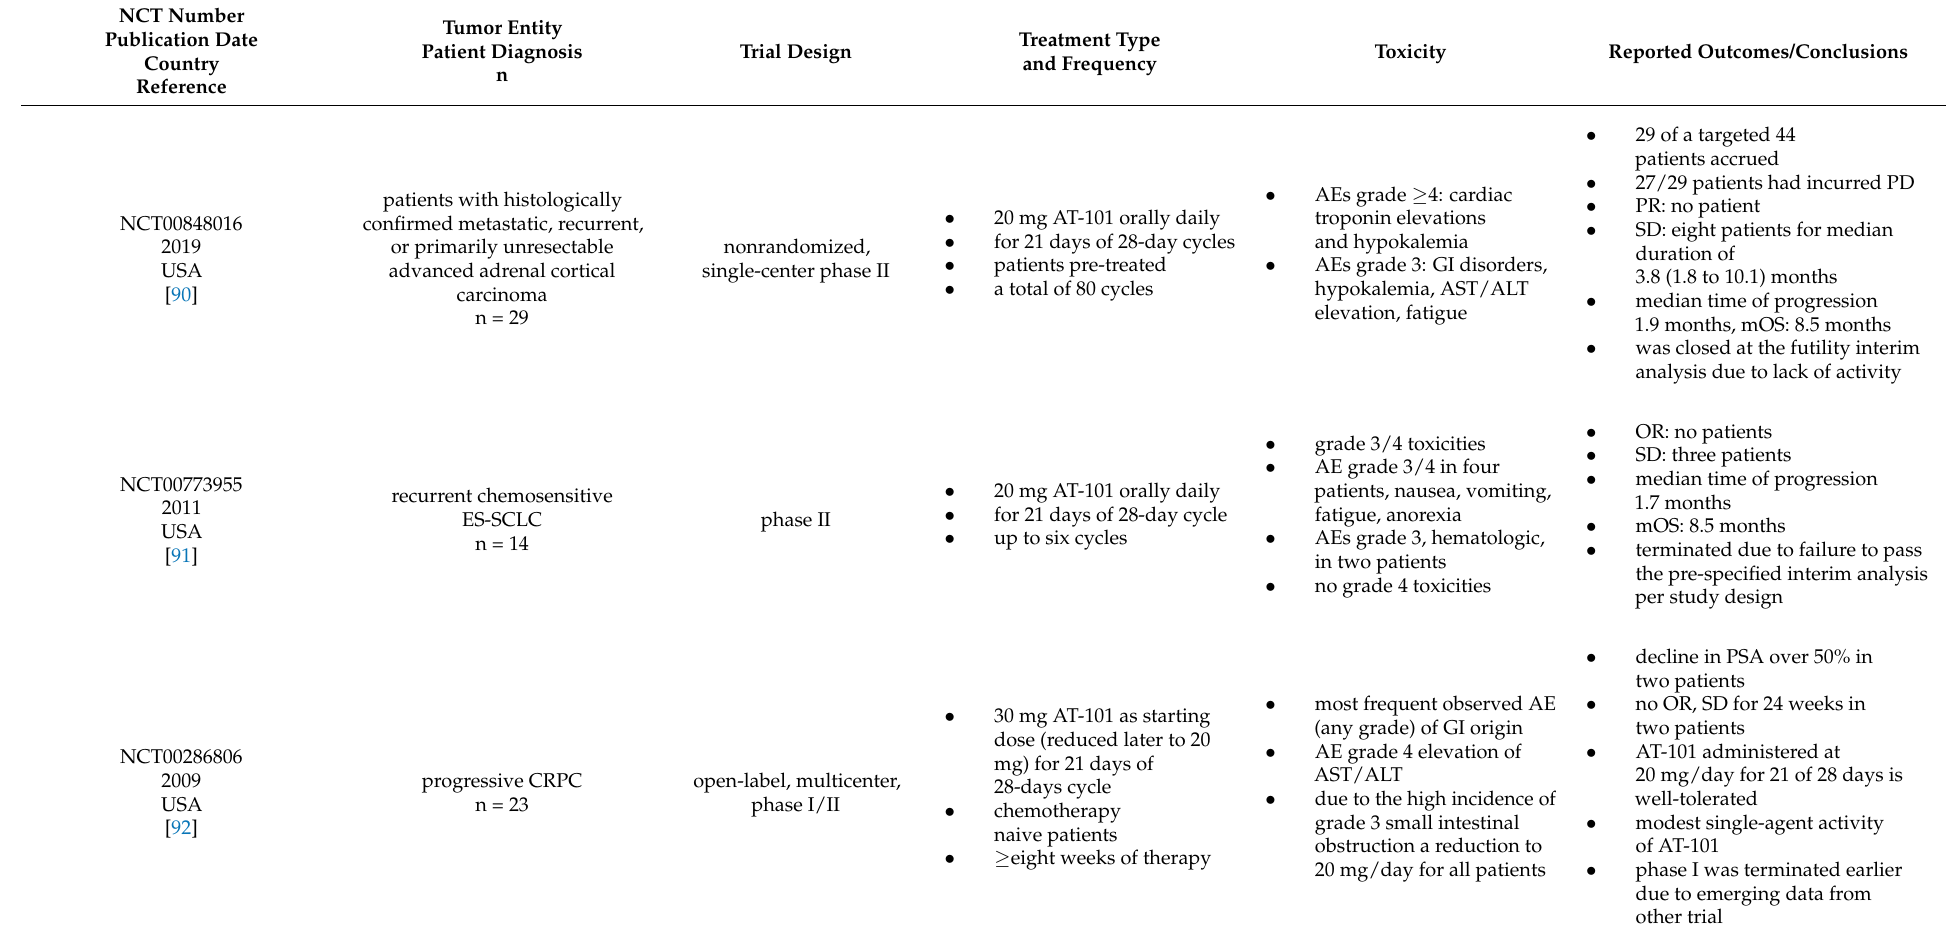
Table 1. Oral application of single-agent gossypol/AT-101 investigated in cancer patients in Phase I and II